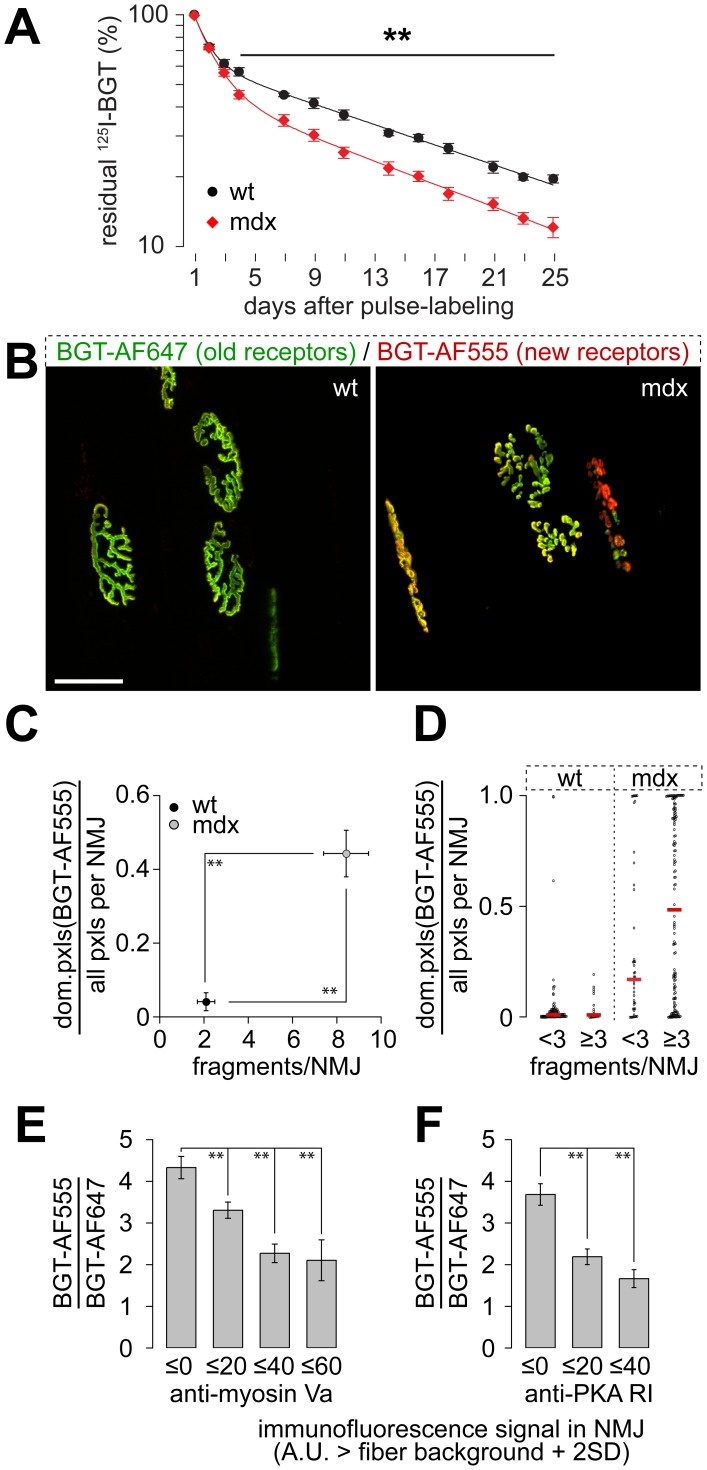
Lifetime of AChRs is reduced in dystrophic muscles and correlates with synaptic integrity and subsynaptic enrichment of myosin Va and PKA-RI.A: Tibialis anterior muscles of wildtype (wt) and mdx mice were pulse-labeled with 125I-BGT on day 0. Subsequently, residual 125I-emission was measured repetitively in the live animals at indicated time points from these muscles in situ. For the duration of measurements (10 min), mice were anaesthetized with isofluorane. Data represent mean ± SEM (n = 5 mice). Welch-test revealed significant differences between wildtype and mdx values, ** p<0.01. B–F: Tibialis anterior muscles were injected with BGT-AF647 (old receptors). Ten days later, muscles were exposed, injected with BGT-AF555 (new receptors), and then monitored with in vivo confocal microscopy (B–D). Subsequently, muscles were sliced, immunostained, and analyzed with confocal microscopy (E–F). B: Representative maximum z-projections of wildtype and mdx NMJs as indicated. Old and new receptor signals are shown in green and red, respectively. Pixels with similar intensities of both dyes appear in yellow. Scale bar, 50 µm. C: Graph showing the fraction of pixels with new receptor signals dominating over old receptor signals in individual NMJs as a function of the number of fragments per NMJ. Data represent mean ± SEM (n = 4 wildtype muscles, n = 8 mdx muscles. 109 and 191 NMJs were analyzed for wildtype and mdx, respectively). Significance was tested with Welch test, ** p<0.01. D: Graph depicts all individual values of the fractions of pixels with new receptor signals dominating over old receptor signals in NMJs. Values were grouped in NMJs with less than 3 fragments and NMJs with 3 or more fragments. Red lines indicate medians. Note the large variance in mdx. Same data set as in C. E–F: Correlations of subsynaptic myosin Va (E) and PKA-RI enrichment (F) with the apparent turnover of AChRs. Tibialis anterior muscles used for in vivo imaging (B–D) were sliced transversally and immunostained for myosin Va or PKA-RI. Ratio of old and new receptors and the accumulation of myosin Va or PKA-RI were determined for each synapse (n = 5 muscles; 651 and 340 NMJs were quantified for myosin Va and PKA-RI, respectively). Significance was tested with Welch test, ** p<0.01.